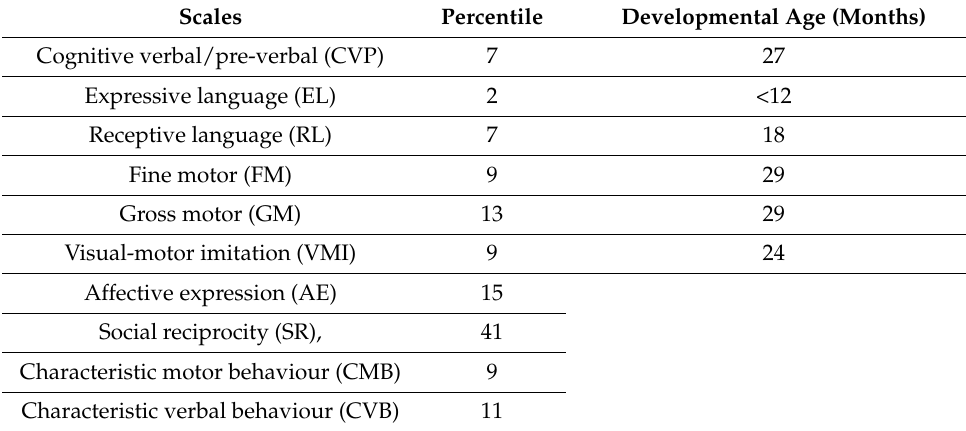
Table 1. Patient’s scores on the PEP-3. Scales